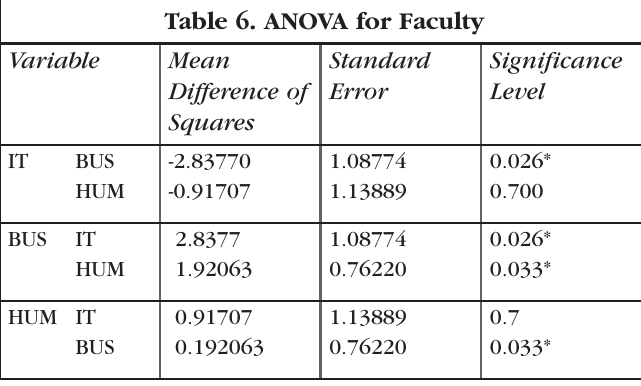
Table 6. ANOVA for Faculty